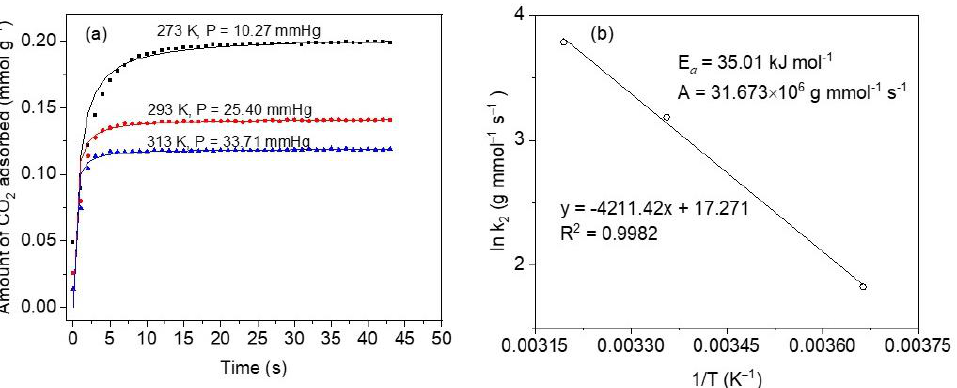
Figure 9. ( a ) CO 2 adsorption kinetics at 273, 298 and 313 K, on sample M11 of CoHCFs; symbols represent experimental data and lines are for eye guidance; pressures up to 33.71 mmHg (4.5 kPa); ( b ) Arrhenius plot obtained from pseudo-second-order model constants.